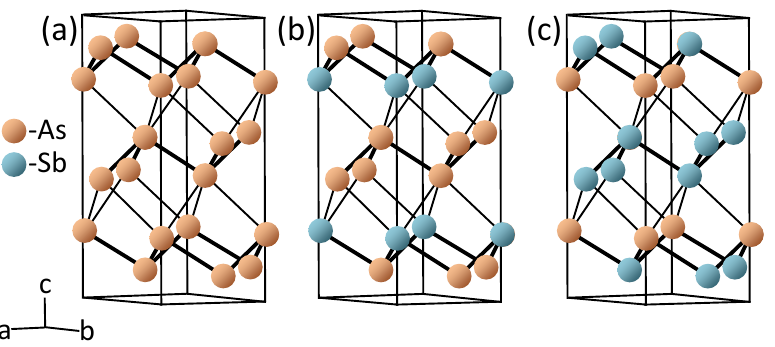
Figure 1. Crystal lattices employed in the calculations for ( a ) As, ( b ) As 0.67 Sb 0.33 , and ( c ) As 0.33 Sb 0.67 . The lattice for pure Sb is similar to that in ( a